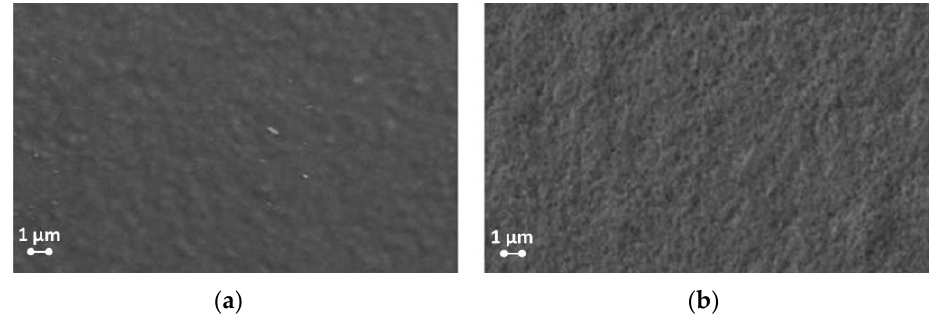
Figure 3. ( a ) SEM images of X55 and ( b ) Spiro-OMeTAD HTLs. The effective perovskite coverage by X55 is related to the good film-forming ability because of the presence of three SFX (spiro[fluorene-9,90-xanthene]) units in the molecular structure, which grants an optimal 3D geometry of the molecule that is able to make a uniform film above the absorber material. Concerning this, Bo et al. reported the absorption and photoluminescence (PL) spectra of X55 and Spiro-OMeTAD in toluene [17]. The three SFX units involve a larger conjugated system of X55 with respect to Spiro-OMeTAD, which causes the red shift of the X55 emission band. X55 and Spiro-OMeTAD have an absorption band in the visible (peak at 406 nm) and UV (peak at 388 nm) light region, respectively. In both cases the emission bands are red shifted. As reported in literature, the charge recombination loss reduction improves the charge collection efficiency and device performance (Figure 2) [17]. The steady state PL helps explain the hole transfer process at the perovskite-HTM interface and the higher current density with X55 HTM with respect to Spiro-OMeTAD HTM. HTM/PVSK combination lowers PL intensity with respect to the PVSK layer [27]. The interfacial hole transfer between X55 and PVSK is higher with respect to Spiro-OMeTAD and PVSK, because of the PL quenching (i.e., the PL intensity is lower than in the second case) (Figure 4).